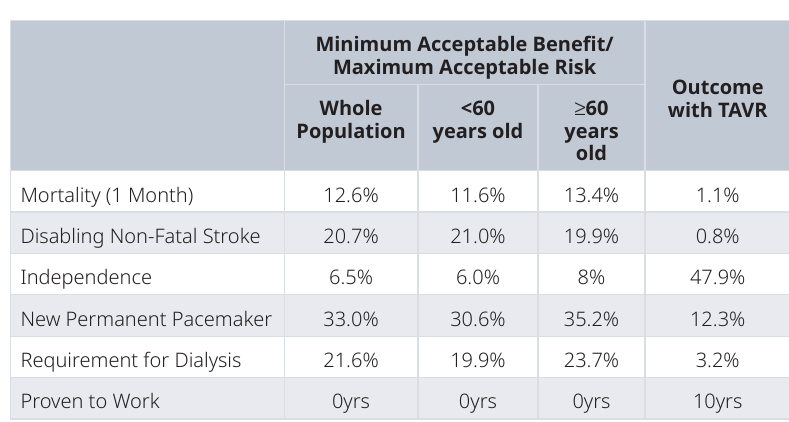
Table 6. Threshold Analysis.